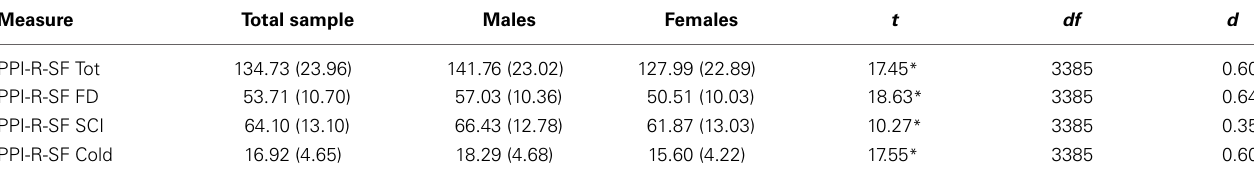
Table 1 | Means and standard deviations, and sex differences, for psychopathy variables. Measure Total sample